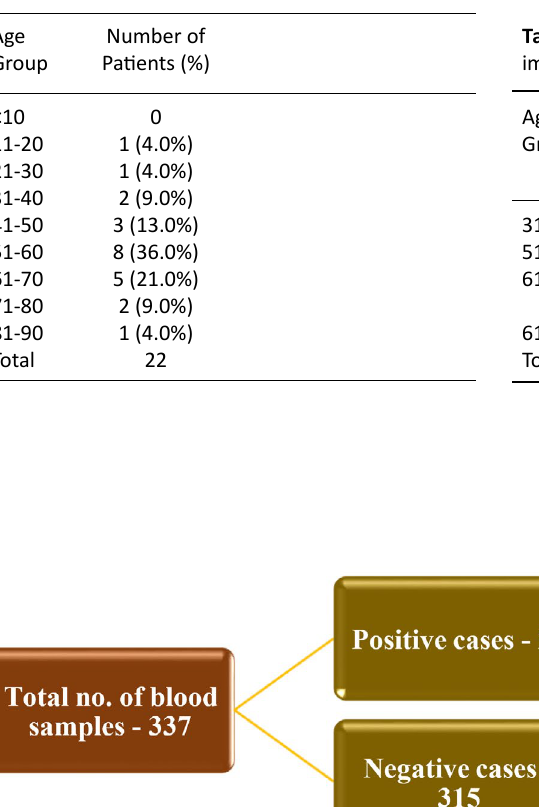
Table 1. Age distribution in study population